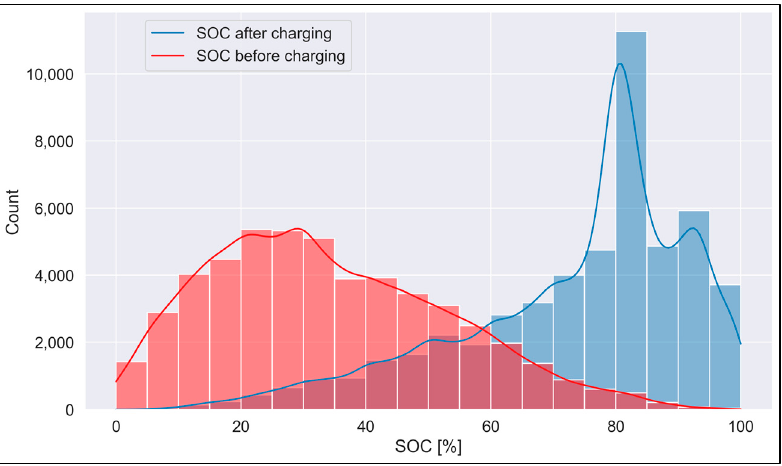
Figure 6. Histogram of DCFC SOC before and after